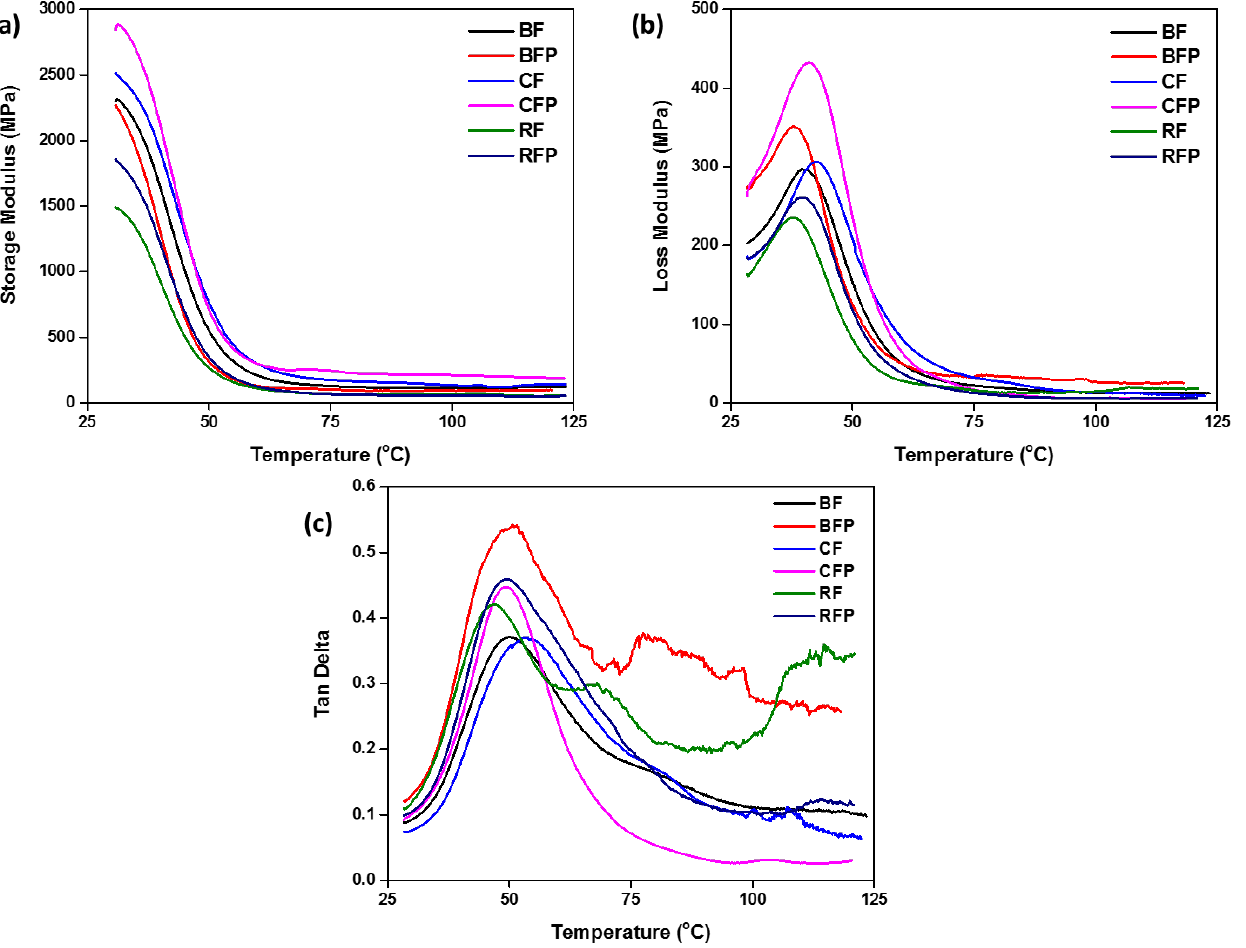
Figure 5. The comparison of the composites’ dynamic mechanical analysis shows ( a ) storage modulus, ( b ) loss modulus, and ( c ) Tan Delta.